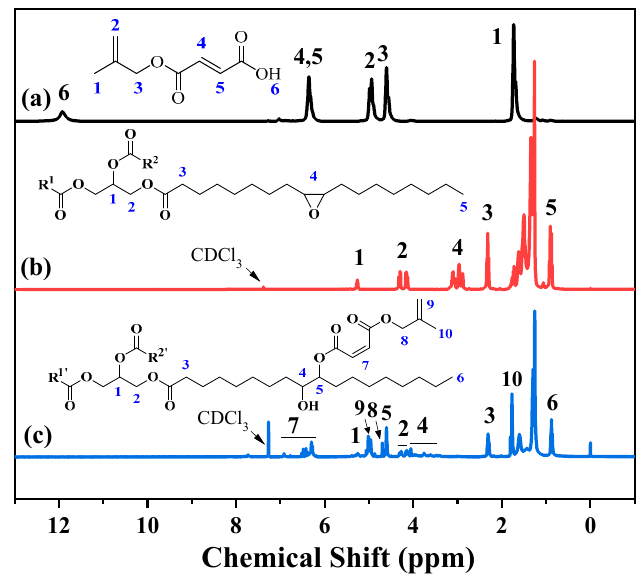
Figure 2. 1 H NMR spectra of ( a ) MAAMA, ( b ) ESO, and ( c ) MMESO.